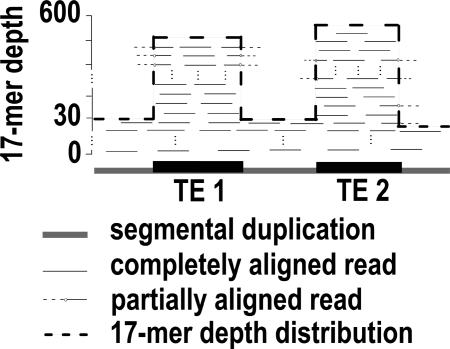
TEs within Segmental DuplicationsIf the duplication is of sufficiently high copy number, it will be assembled as a “ReAS TE,” and what we need to do afterwards is find the boundaries of the TEs within this assembled duplication. On the assumption that TEs have much higher copy numbers, TE boundaries can be identified by sudden changes in depth, accompanied by many partially aligned reads.